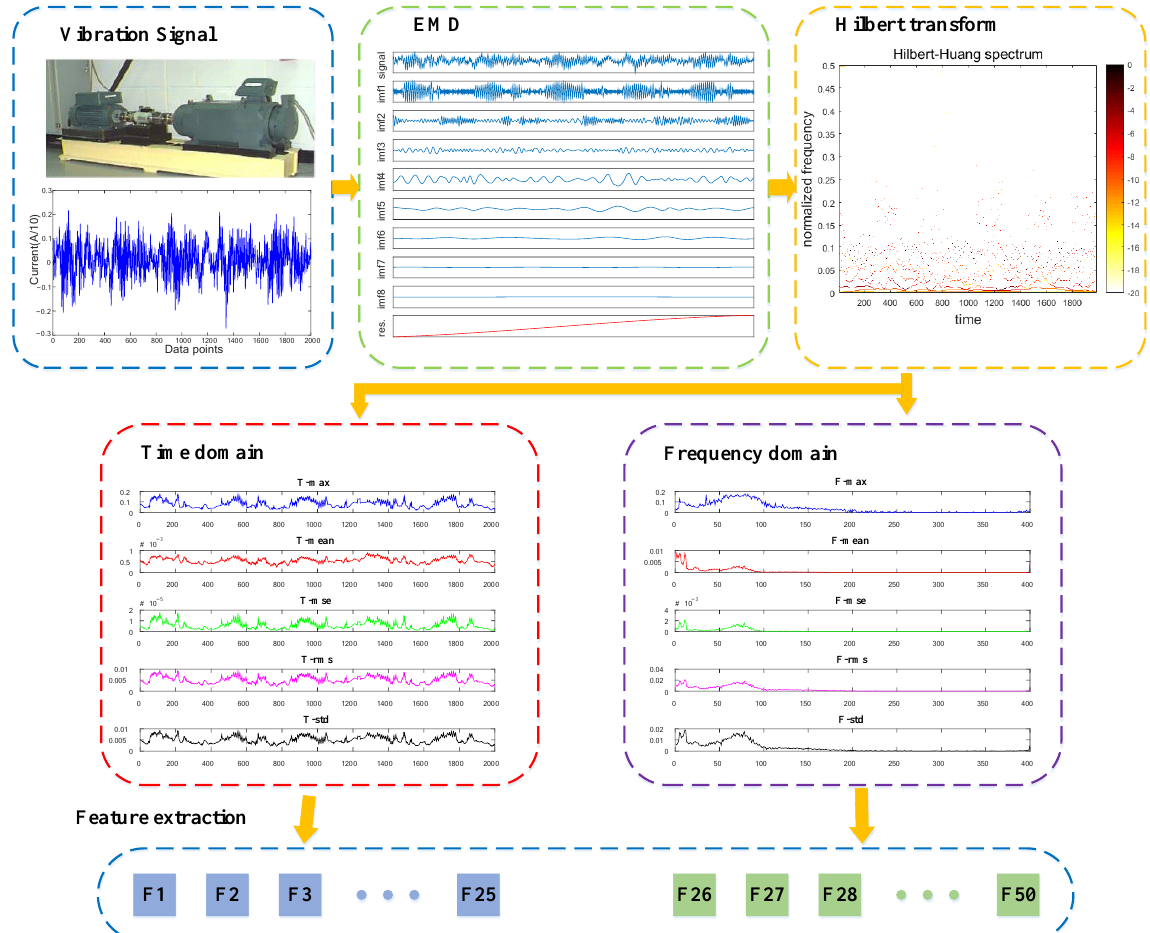
Figure 2. Feature extraction process diagram.